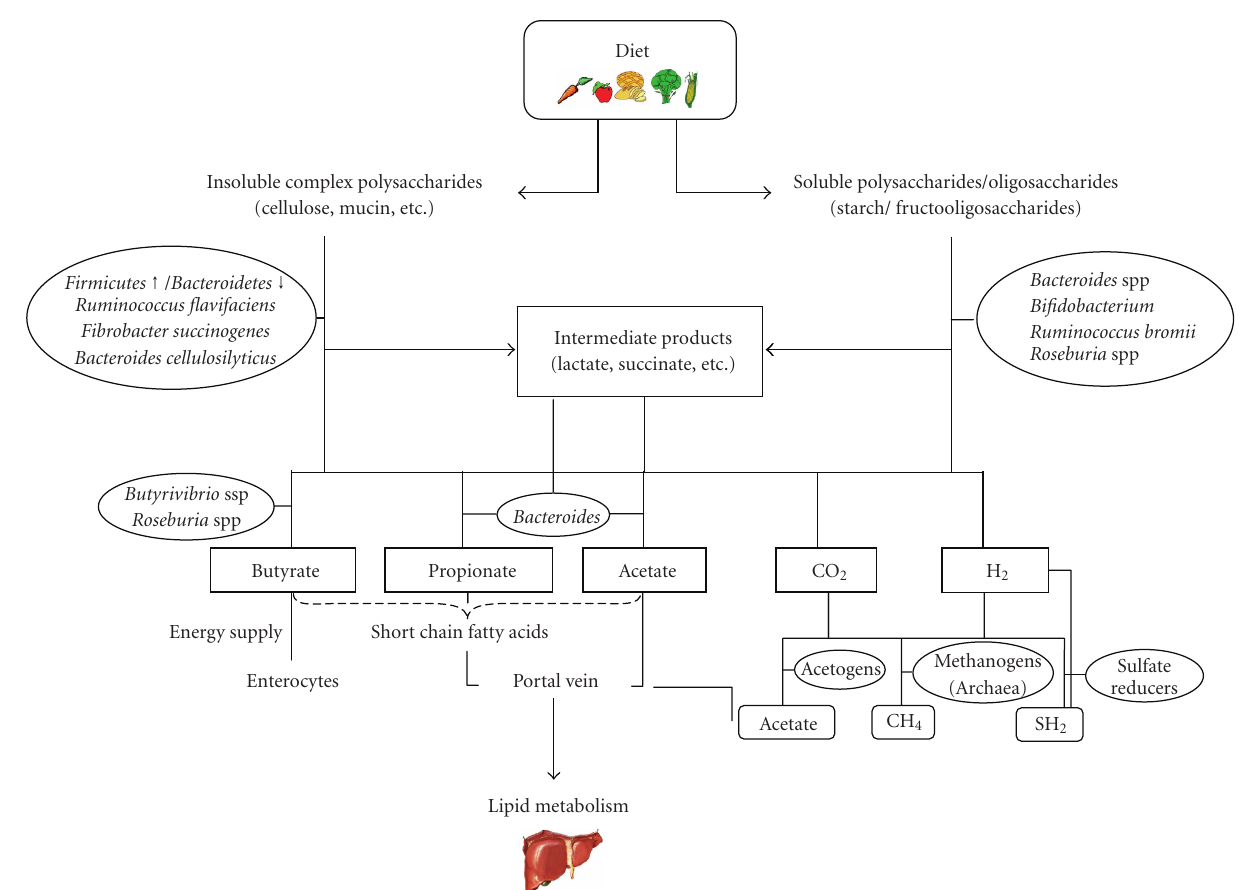
Figure 1: Schematic diagram of the main metabolic pathways of dietary poly- and oligosaccharides in the gut ecosystem.